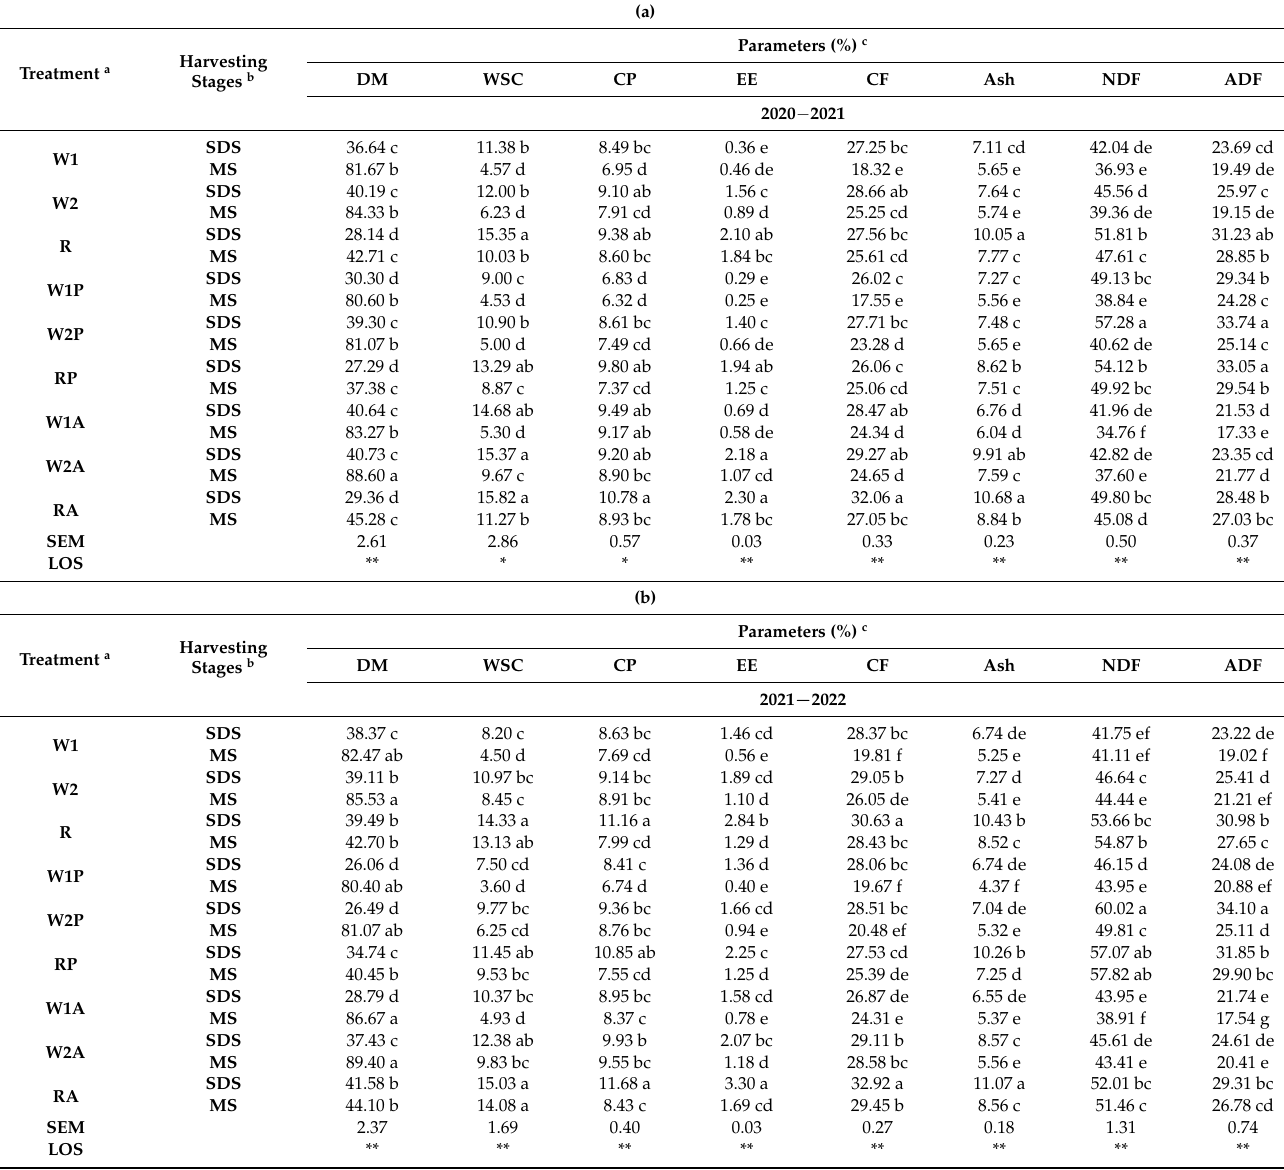
Table 5. ( a ) Effects of cereal–legume mixed cropping on nutrient compositions of fresh forage during 2020–2021 cropping season. ( b ) Effects of cereal–legume mixed cropping on proximate compositions of fresh forage during 2021–2022 cropping